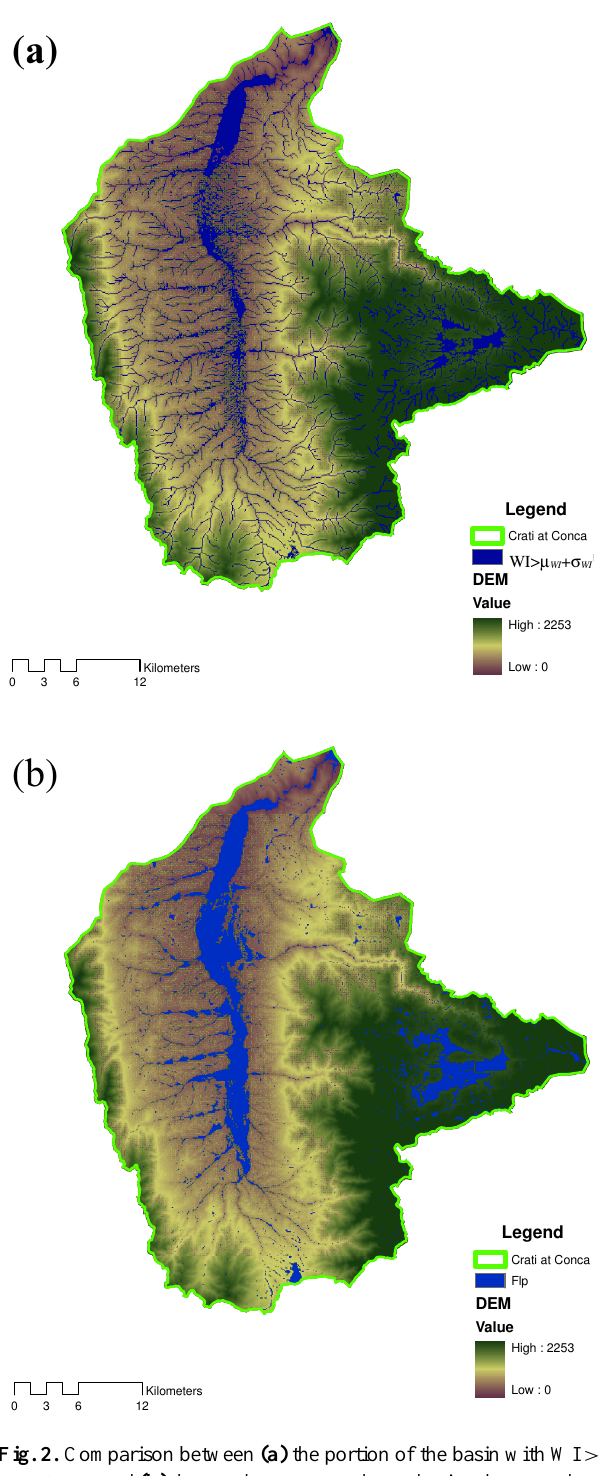
Fig. 2. Comparison between (a) the portion of the basin with WI > µ WI + σ WI and (b) the floodprone areas defined using the procedure proposed by Manfreda et al. (2011).